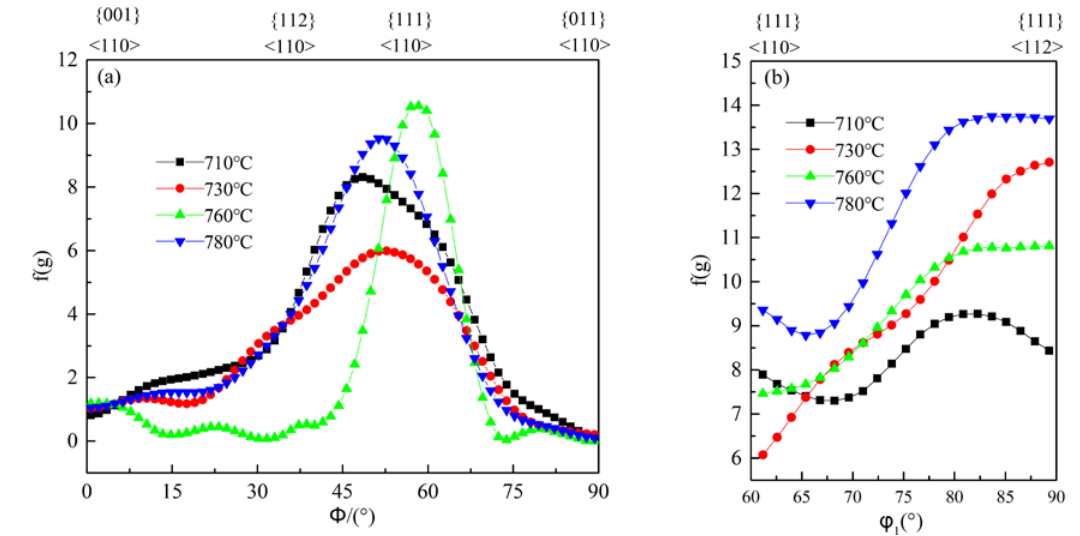
Figure 6. Texture intensity distributions along α ( a ) and γ ( b ) orientation lines at different annealing temperatures.